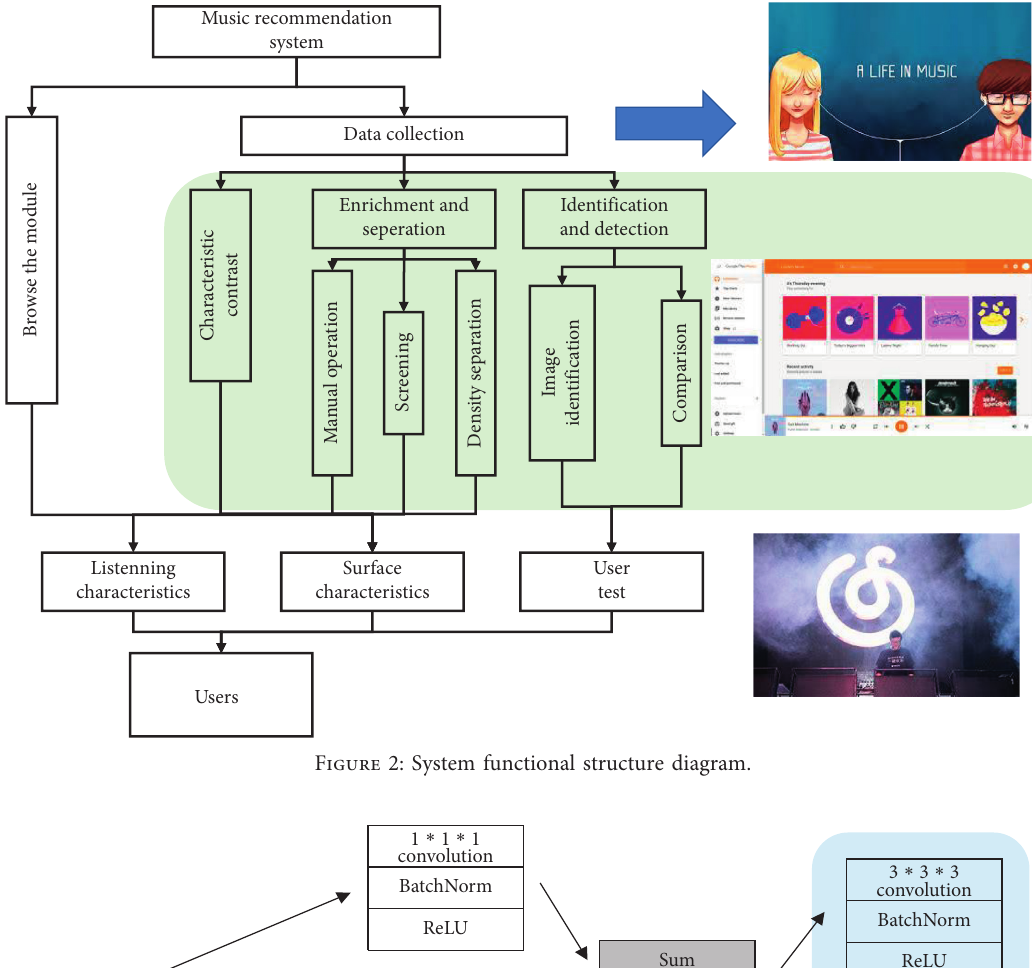
Figure 2: System functional structure